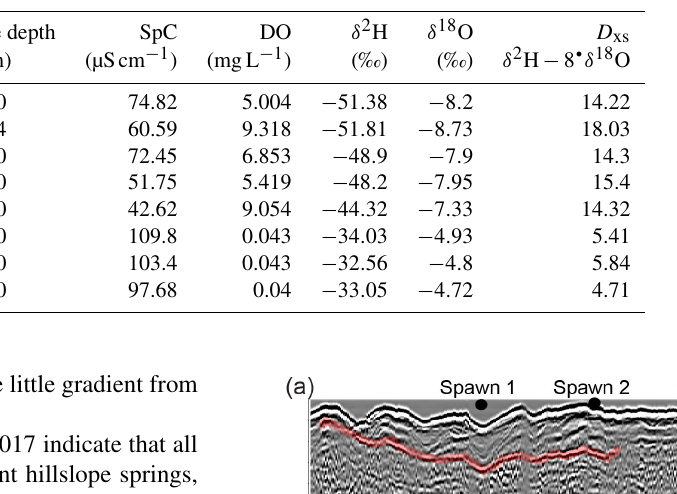
Table 2. This table lists 2017 drive point pore-water chemistry and stable water isotope data collected in a subset of major stream-bed groundwater-seepage zones, zones of observed repeat trout spawning, and from springs located above the waterline along the same hillslope as the meander cutbanks of Spawn 1 and Spawn 2.